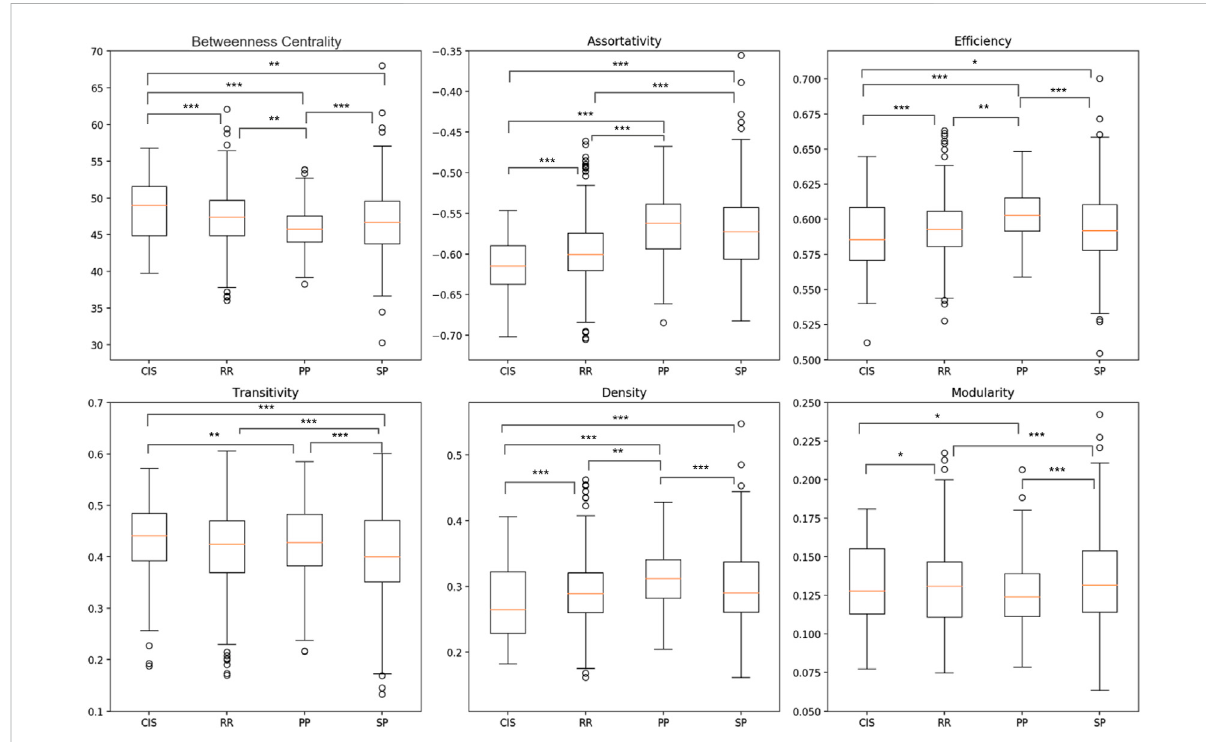
FIGURE 5 Boxplot comparison between four MS clinical pro fi les over six global graph metrics using FSAverage atlas. Differences between clinical pro fi les were determined employing a generalized mixed effect model with age and sex as controlling factors (*p < 0.05; **p < 0.01; ***p <